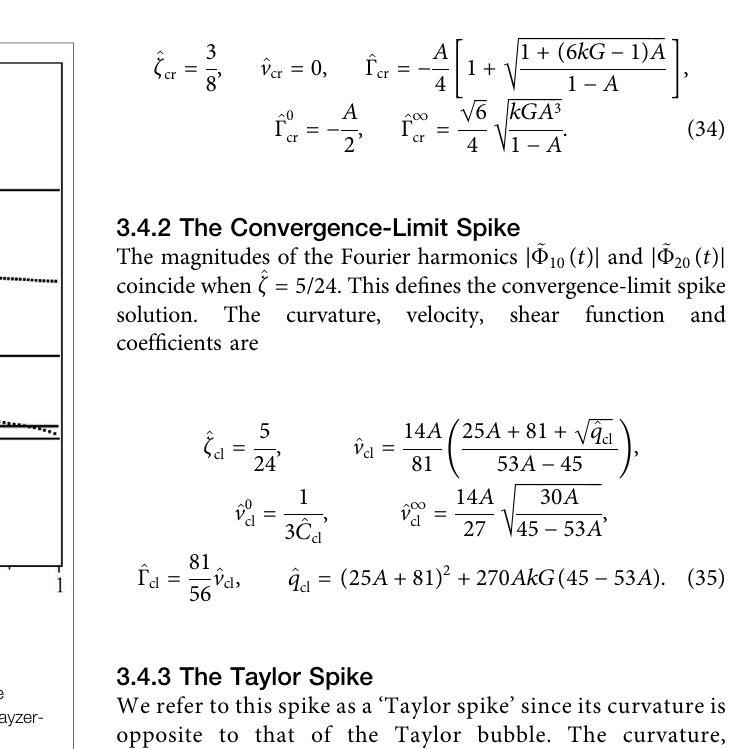
FIGURE 6 | Layzer-drag (LD) bubble velocity and shear function as functions of acceleration parameter kG for various values of the Atwood number.